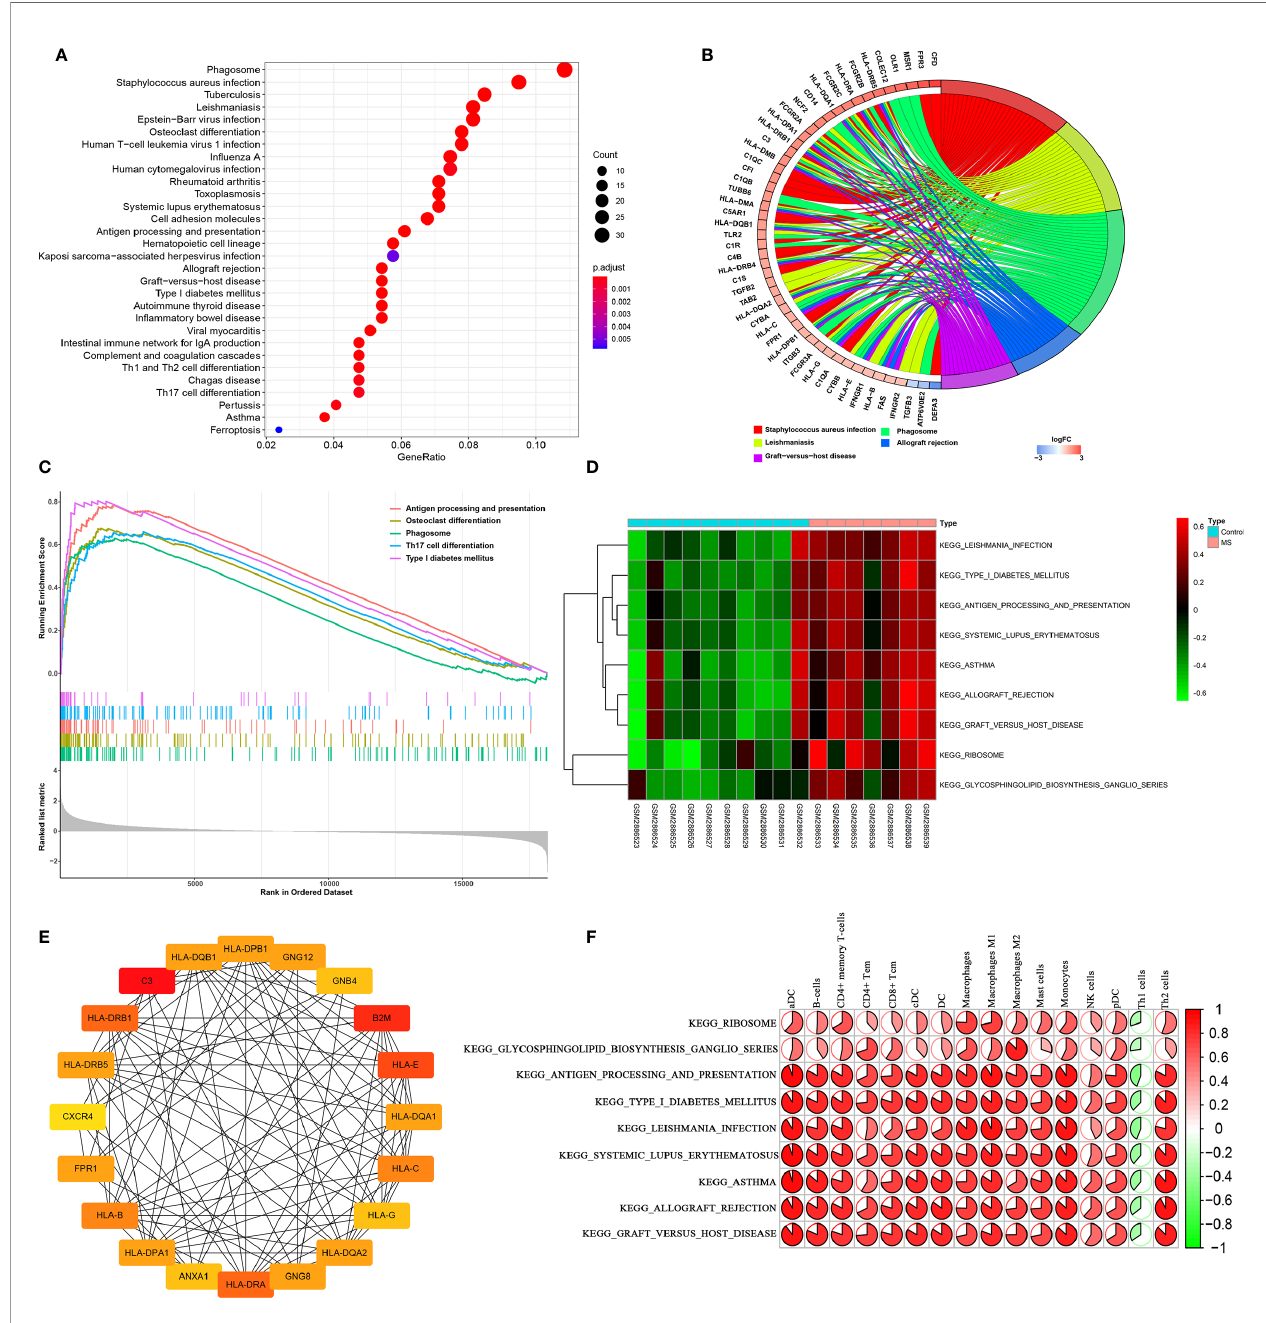
FIGURE 4 | Enrichment analysis and correlation analysis of DEGs in the KEGG pathway. (A, B) The distribution of DEGs in the KEGG pathway. (C, D) GSEA and GSVA for signi fi cantly enriched pathways in MS and control groups. (E) Hub genes with the top 20 degrees of interaction were identi fi ed using Cytohubba. (F) Correlation analysis based on Pearson r value between immune cells and KEGG key pathways. P<0.05 and |log2FC| ≥ 0.2 were de fi ned as signi fi cant